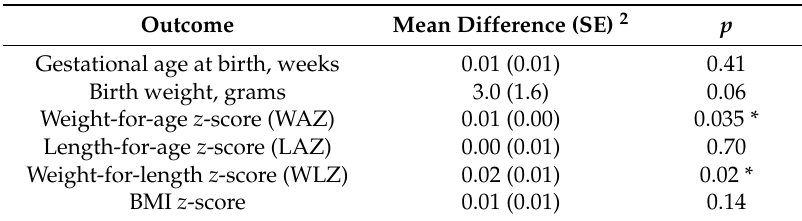
Table 2. Maternal Plasma 25(OH)D Concentrations 1 and Pregnancy Outcomes. Mean Difference (SE) 2 p